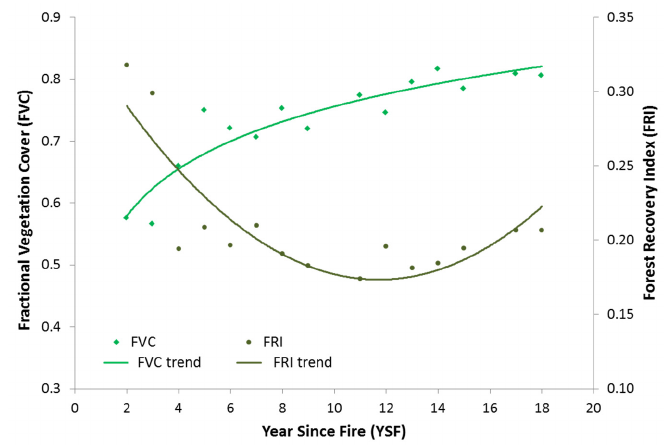
Figure 2. Temporal trend of post-fire forest patterns measured by FVC (Fractional Vegetation Cover) and FRI (Forest Recovery Index) from Landsat time series data. The trends were fitted using the logistic and polynomial regressions based on the annual mean values of FVC and FRI and the year since fire (YSF), respectively (see [23]). Only the periods showing an increasing trend of the FVC and FRI were selected to calculate the forest recovery rate after fire using the Equations (3) and (4).